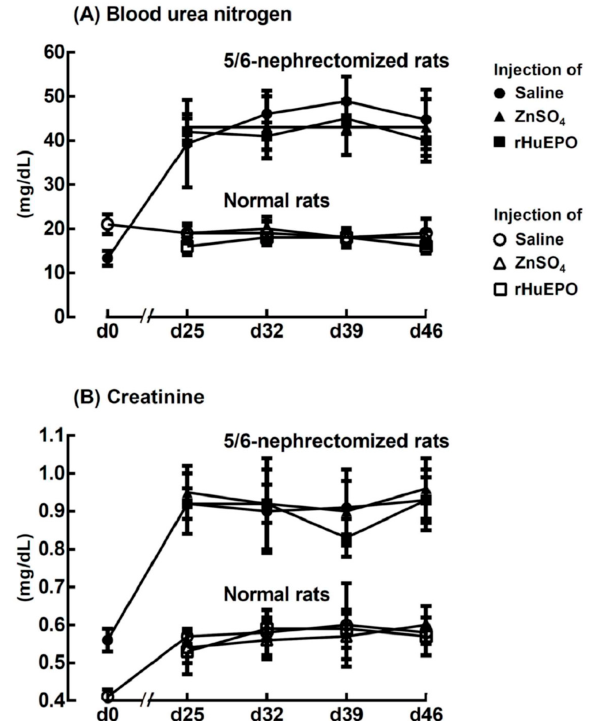
Figure 5. E ff ect of injection of saline, ZnSO 4 , or rHuEPO on ( A ) blood urea nitrogen and ( B ) creatinine in the 5 / 6-nephrectomized and normal rats that had been injected with saline, ZnSO 4 , or rHuEPO on day 25, 32, and 39, respectively. The results are the mean ± SD for each time point ( n =